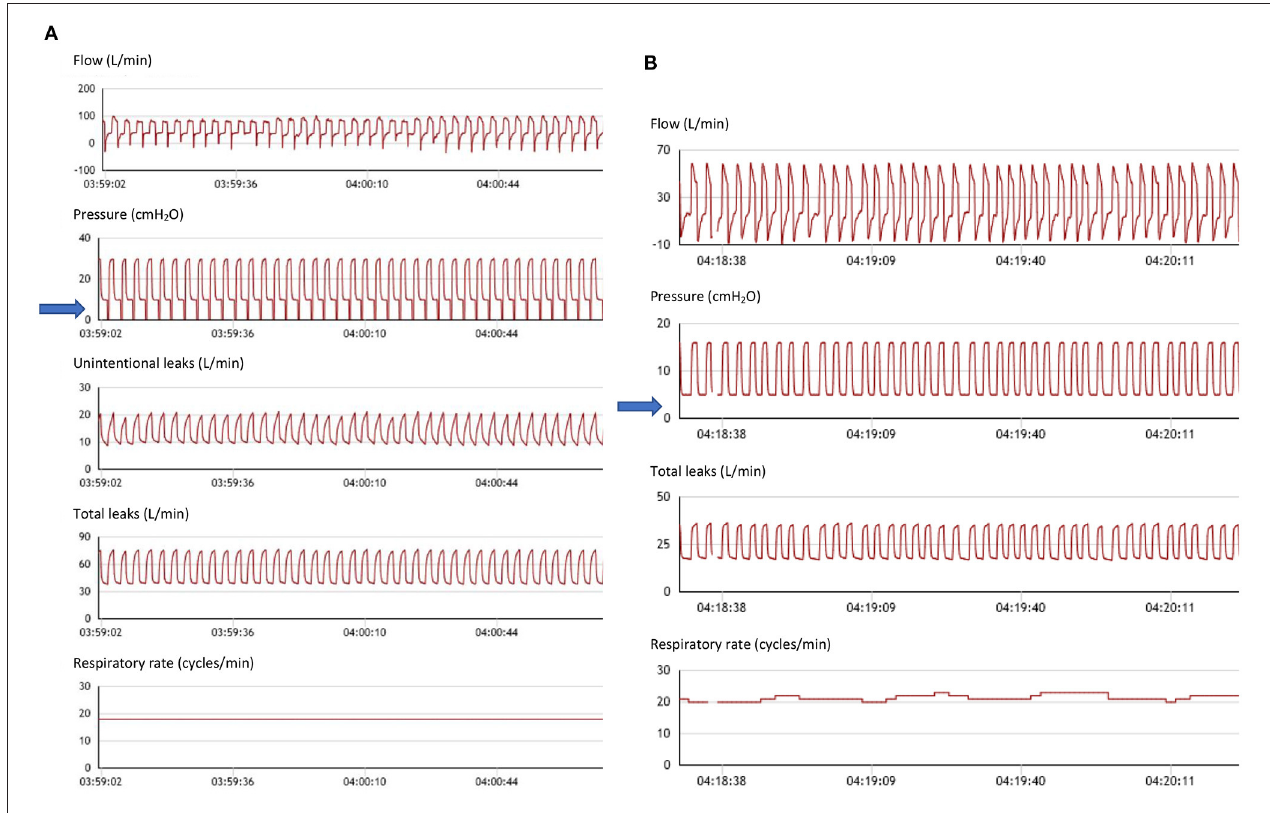
FIGURE 2 | Spontaneous vs. controlled cycles. (A) From top to bottom: flow (including leaks), pressure, unintentional leaks (i.e.: difference between total leak flow and estimated flow through the leak valve (small holes) of the mask), total leaks, and respiratory rate. Seventy six-year-old female subject with kyphoscoliosis, obstructive sleep apnea and obesity; ventilator settings: ST mode (spontaneous/timed); IPAP (Inspiratory positive airway pressure): 30 cmH 2 O; EPAP: 10 cmH 2 O (Expiratory positive airway pressure); Back-up respiratory rate (BURR): 18 cycles/min. Nasal mask (facial mask not tolerated). Flow tracing shows intermittent flattening of inspiratory curve suggesting persisting flow limitation (upper airway collapse to be compensated by increasing EPAP). Blue arrow: pressure tracing shows vertical marks associated with each cycle indicating controlled cycle (i.e., delivered by ventilator). On this segment, patient is continuously on back-up respiratory rate. Low level of intentional leaks. (B) From top to bottom: flow (including leaks), pressure, total leaks, and respiratory rate. Fifty four-year-old male subject with restrictive disorder. Ventilator settings: ST mode (spontaneous/timed); IPAP (Inspiratory positive airway pressure): 16 cmH 2 O; EPAP: 5 cmH 2 O (Expiratory positive airway pressure); Back-up respiratory rate (BURR): 16 cyc/min; nasal mask. Blue arrow: as opposed to (A) , all cycles are triggered by the patient (i.e., spontaneous). Normal aspect of flow and pressure tracings. DirectView software, Philips